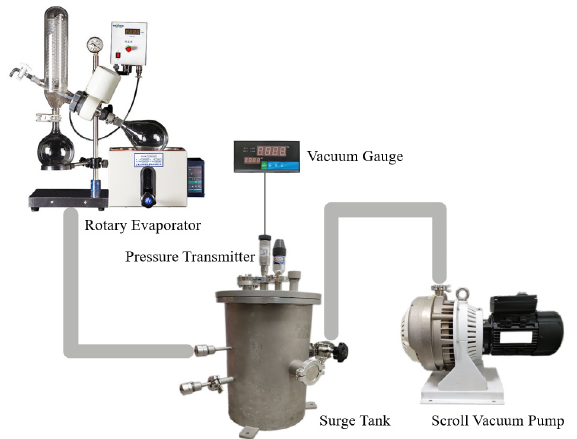
Figure 2. The K 2 CO 3 /EVM composite material preparation equipment.